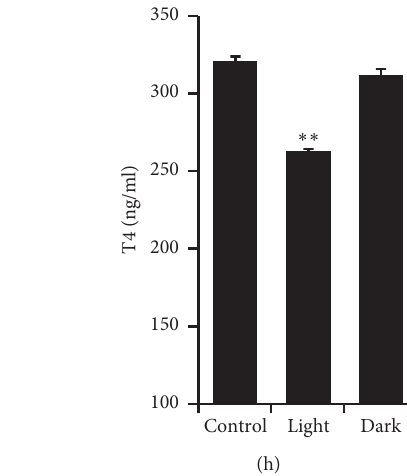
Figure 2: Changes in the levels of reproductive and thyroid hormones. Serum levels of (a) FSH (mIU/ml), (b) LH (mIU/ml), (c) testosterone (ng/ml), (d) prolactin (ng/ml), (e) E2 (pg/ml), (f) TSH ( µ IU/ml), (g) T3 (ng/ml), and (h) T4 (ng/ml) in male rats after prolonged light or prolonged dark exposure for 12 consecutive weeks. Values are expressed as means ± SEM ( n � 8–10 rats). ∗∗ P ≤ 0 . 01 and ∗∗∗ P ≤ 0 . 001 vs the control group by Student’s t